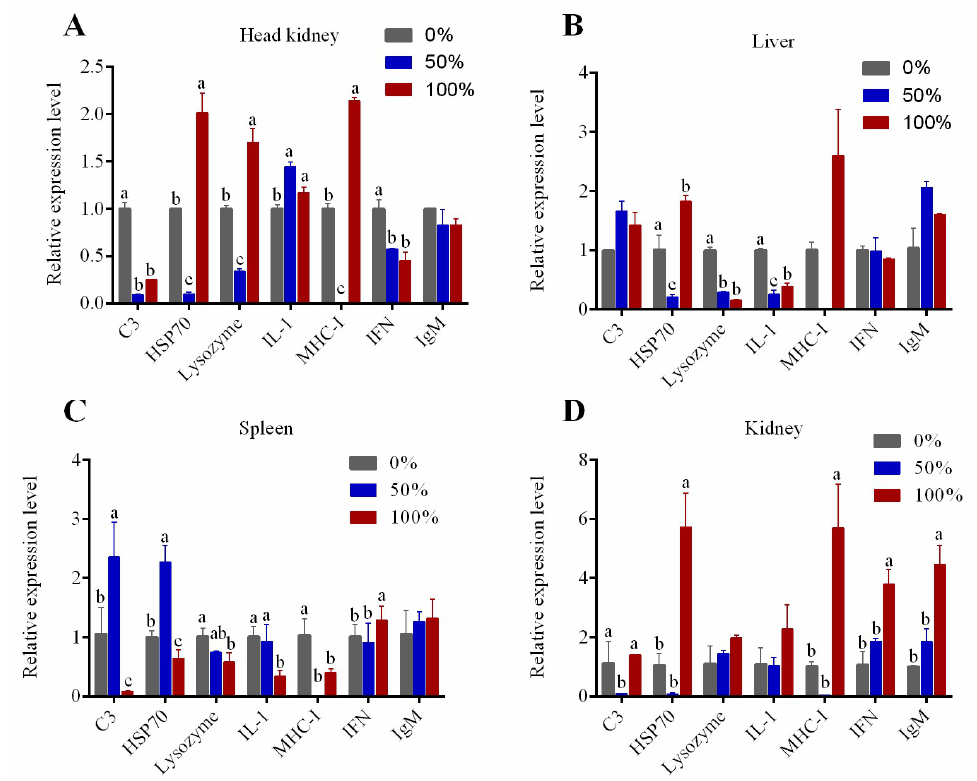
Figure 3. Effect of common reed on expression of immune genes in head kidney ( A ), liver ( B ), spleen ( C ) and kidney ( D ) of grass carp (N = 3). Different letters mean significant difference among groups ( p < 0.05), the same letters or no letters mean no significant difference ( p > 0.05).